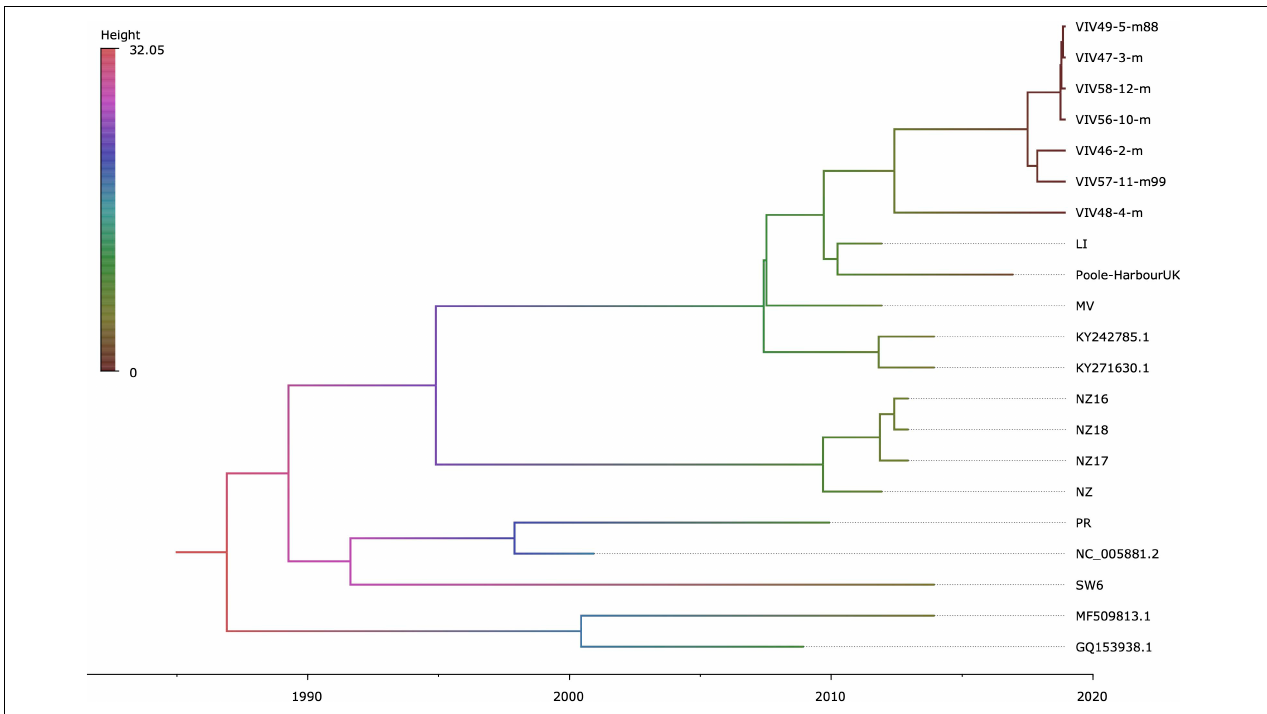
FIGURE 4 | Time-scaled phylogenetic tree of OsHV-1 and chlamys acute necrotic samples. Maximum clade credibility time-calibrated phylogenetic tree generated in BEAST. The tree is scaled in years, with the final sampling year being 2017. The branches are colored accordingly to their mean height across the posterior. This figure was produced with FigTree v1.4.3 (Rambaut,